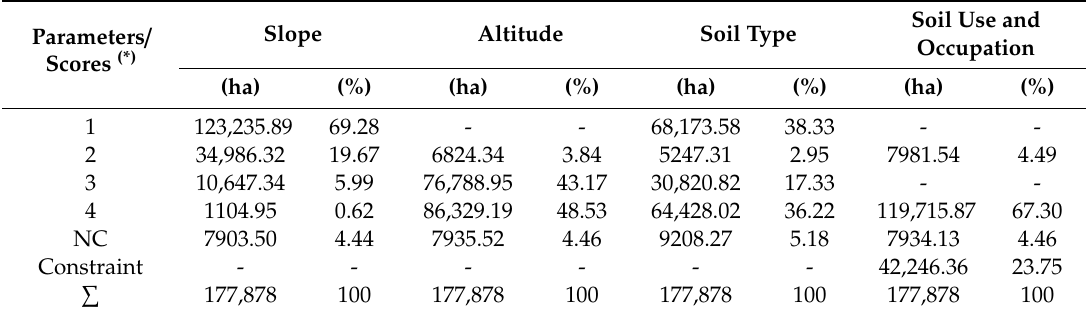
Table 6. Reclassification statistics of the suitability scale maps according to the scores established for each class of